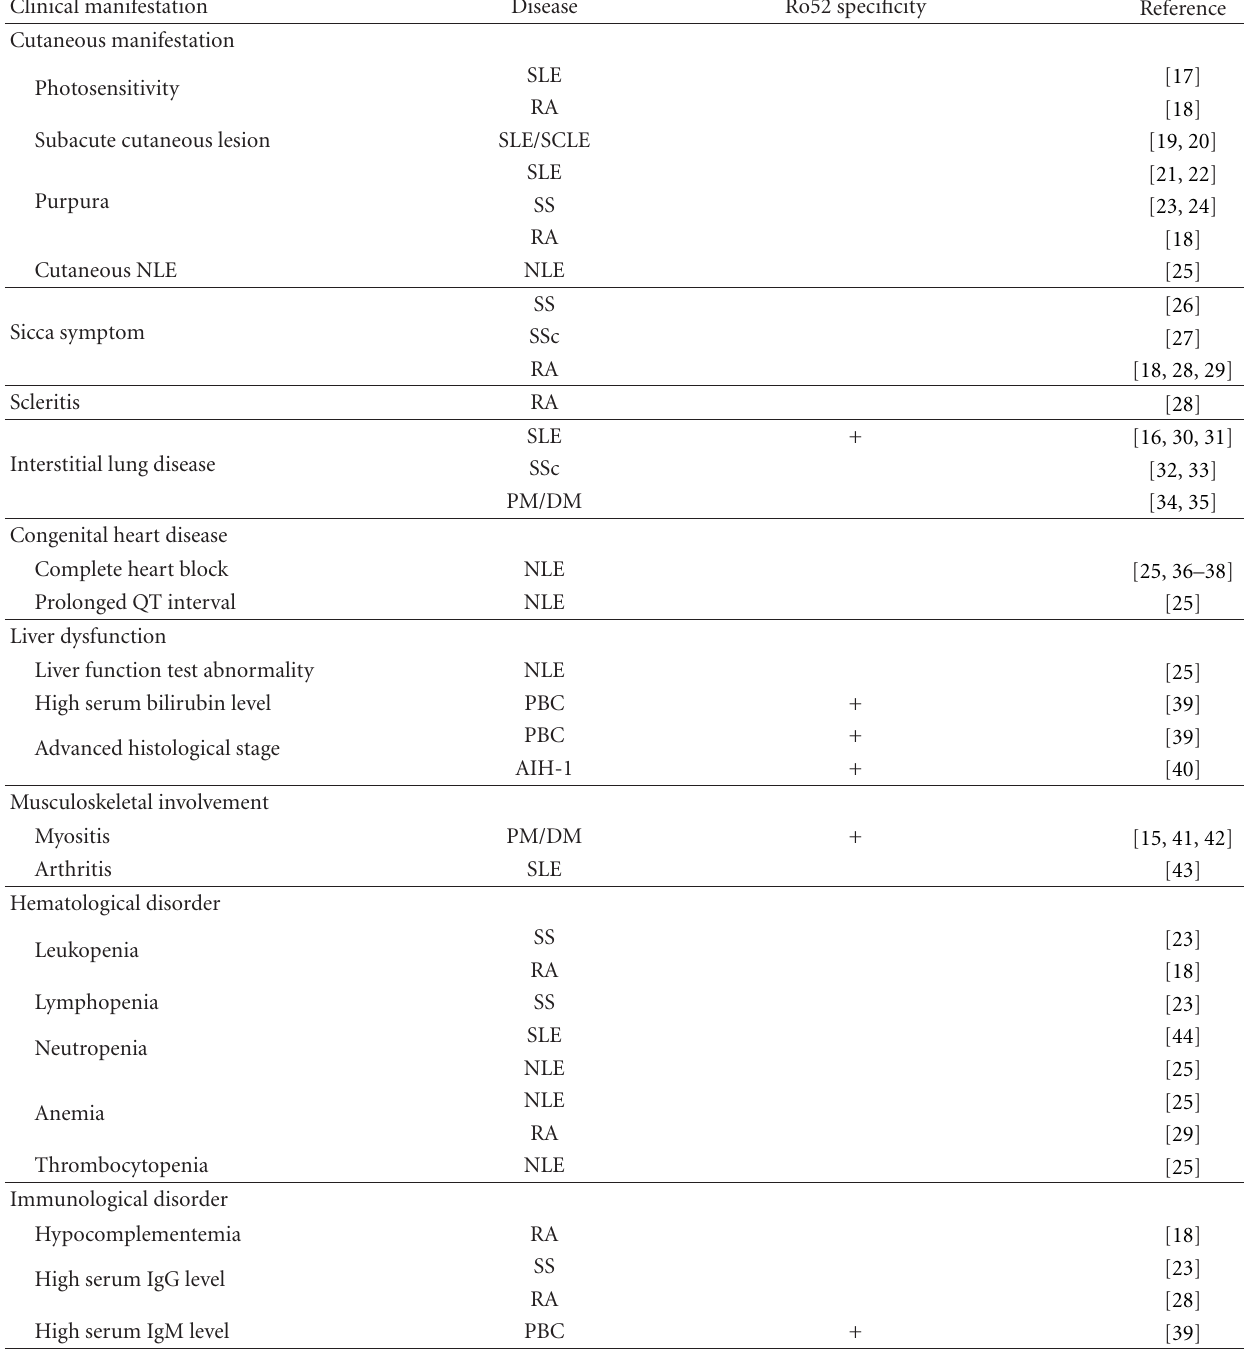
Table 1: Clinical manifestations related to anti-Ro